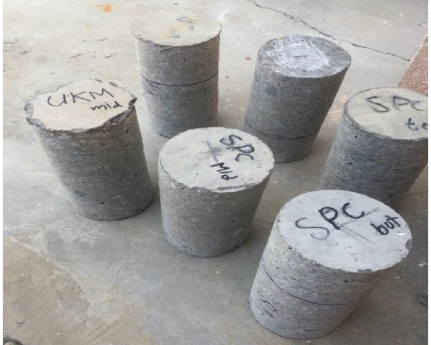
Figure 6: Extracted core samples from the tunnel